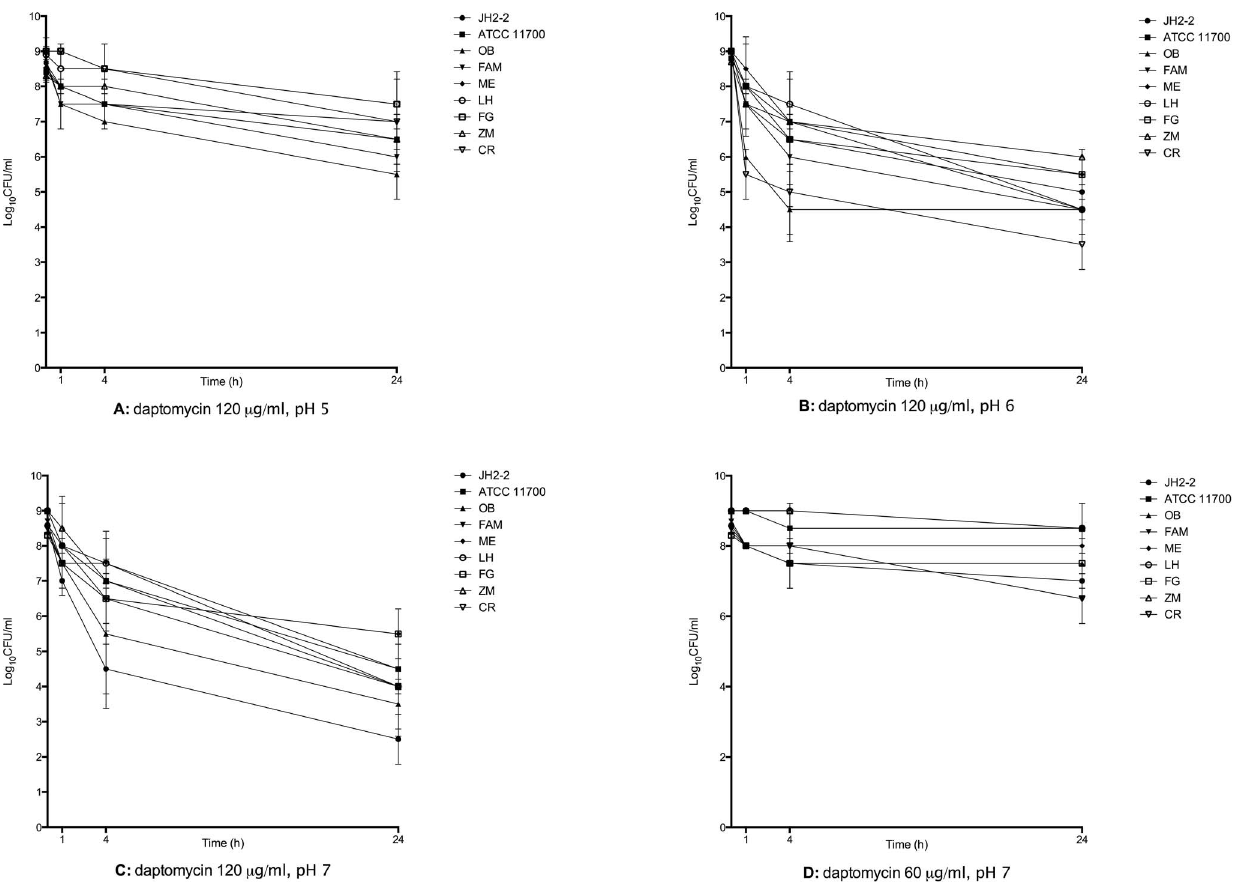
Figure 3. Time kill studies with 9 strains of Enterococcusfaecalis with a high inoculum and stationary growth phase bacteria. Nine strains of Enterococcus faecalis were used, including: 6 clinical strains obtained from patients presenting endocarditis (OB, FAM, ME, LH, FG, ZM); 1 clinical strain obtained from enterococcus bacteriemia without endocarditis (CR) and 2 reference strains (JH2-2, ATCC 11700). Daptomycin at 120 m g/ ml and pH 5 (A) was bacteriostatic on all strains (1 to 2-log reduction). When pH was adjusted to 6 (B), the activity of daptomycin at 120 m g/ml increase with a 3 to 4-log reduction in 4 hours for 3/9 strains and a $ 4-log reduction for 4/9 strains. When pH was adjusted to 7 (C), daptomycin (120 m g/ml) bactericidal activity was optimum. At 4 hours 5/9 strains experienced a 2 to 4-log decrease and at 24 hours, a 3 to 6-log reduction was evidenced for 8/9 strains. Daptomycin at 60 m g/ml and pH 7 (D), alone or in combination did not reduce initial inoculum for 4/9 strains and was bacteriostatic for 5/9 strains after 24 hours (2-log